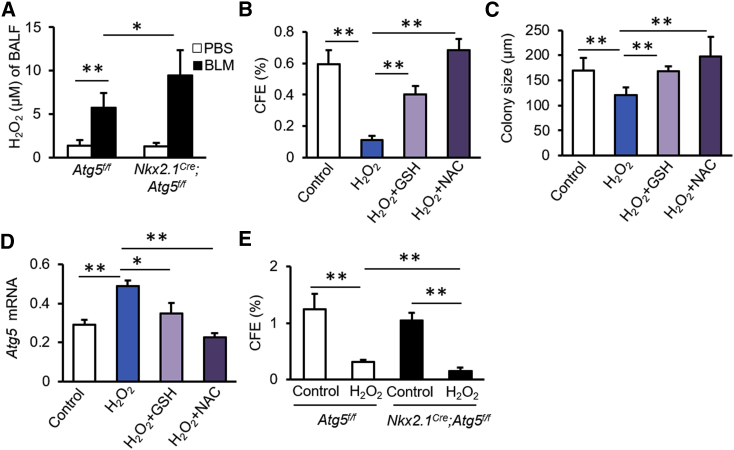
Autophagy Sustains AT2 Cell Proliferation by Repressing H2O2 Production during Injury(A) H2O2 levels in BALF from Atg5f/f and Nkx2.1cre;Atg5f/f mice 14 days after BLM injury (n = 5).(B) CFE of AT2 cells cultured in the presence of H2O2, H2O2 + GSH, or H2O2 + NAC (n = 6).(C) Diameters of colonies under conditions described in (B) (n = 6).(D) Atg5 gene expression in organoid cultures under indicated conditions (n = 6).(E) CFE of AT2 cells isolated from control Atg5f/f and Nkx2.1Cre;Atg5f/f mice in the presence or absence of H2O2 (n = 5). Data are representative of two independent experiments with error bars representing the mean ± SD. ∗p < 0.05, ∗∗p < 0.01.